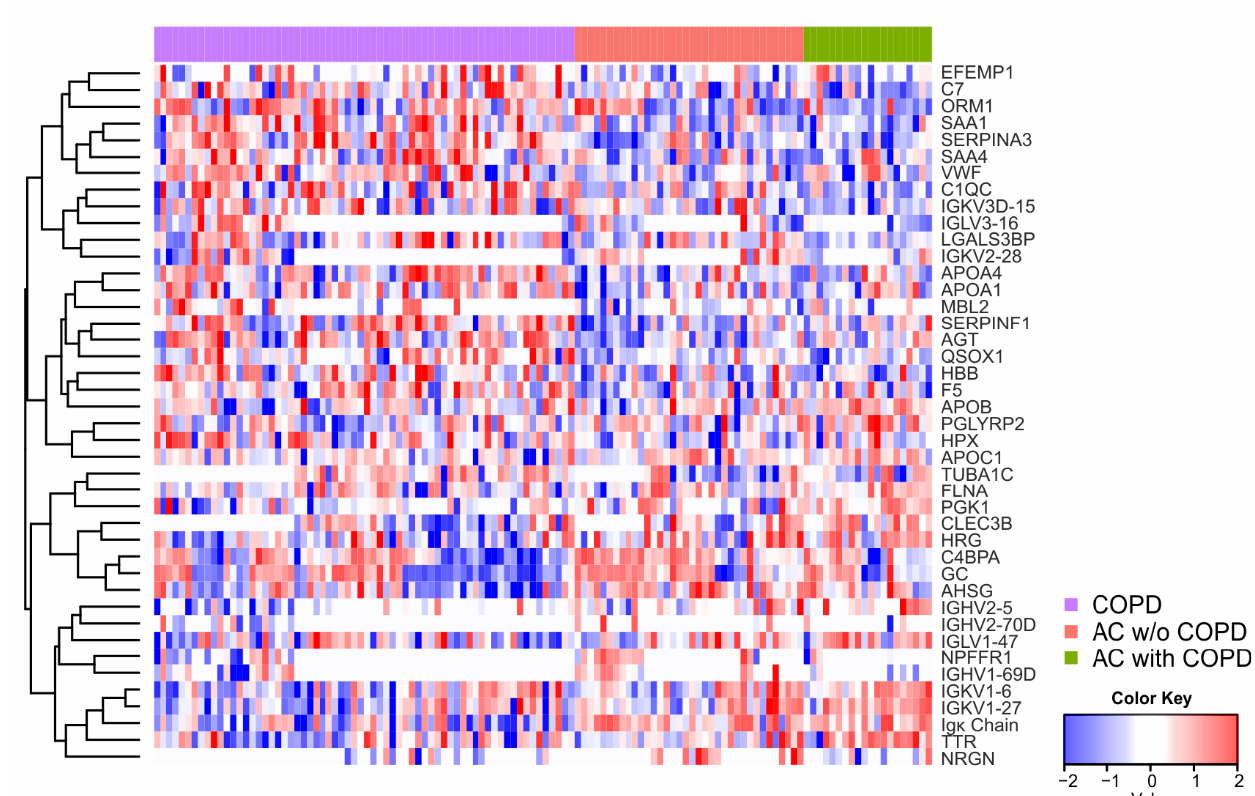
Figure 3. Hierarchical cluster analysis and two-group comparison of proteomics data. Heatmap illustrating hierarchical cluster analysis (distance based on Pearson’s correlation, complete linkage) considering 42 proteins, which passed a p FDR -value threshold ≤ 0.05 calculated using Welch-ANOVA for comparisons between either AC with or without COPD vs. COPD.